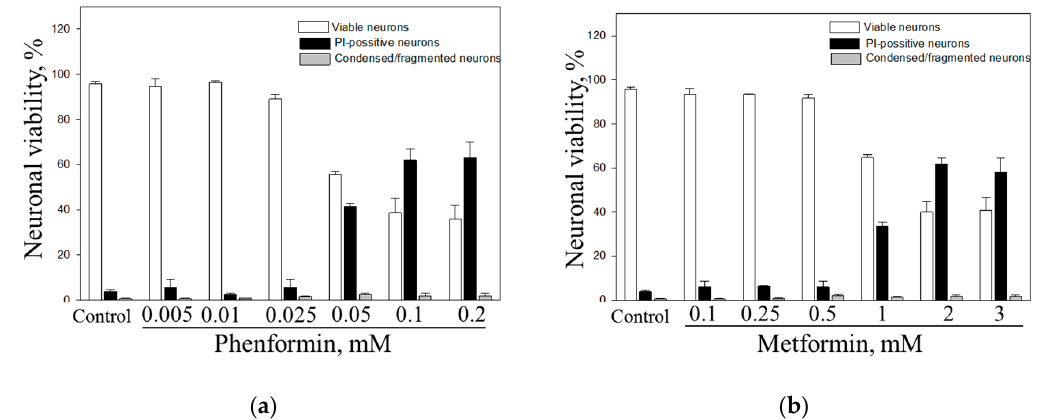
Figure 1. Effect of phenformin ( a ) and metformin ( b ) on neuronal viability in cerebellar granule cells (CGC) cultures. CGC were treated with phenformin and metformin at indicated concentrations. White column—viable neurons (%), black—necrosis (%), grey—apoptosis (%). The number of all neuronal cells (live, apoptotic and necrotic) in the vision field was equal to 100%. The data are presented as means ± standard errors of 3 experiments on separate CGC